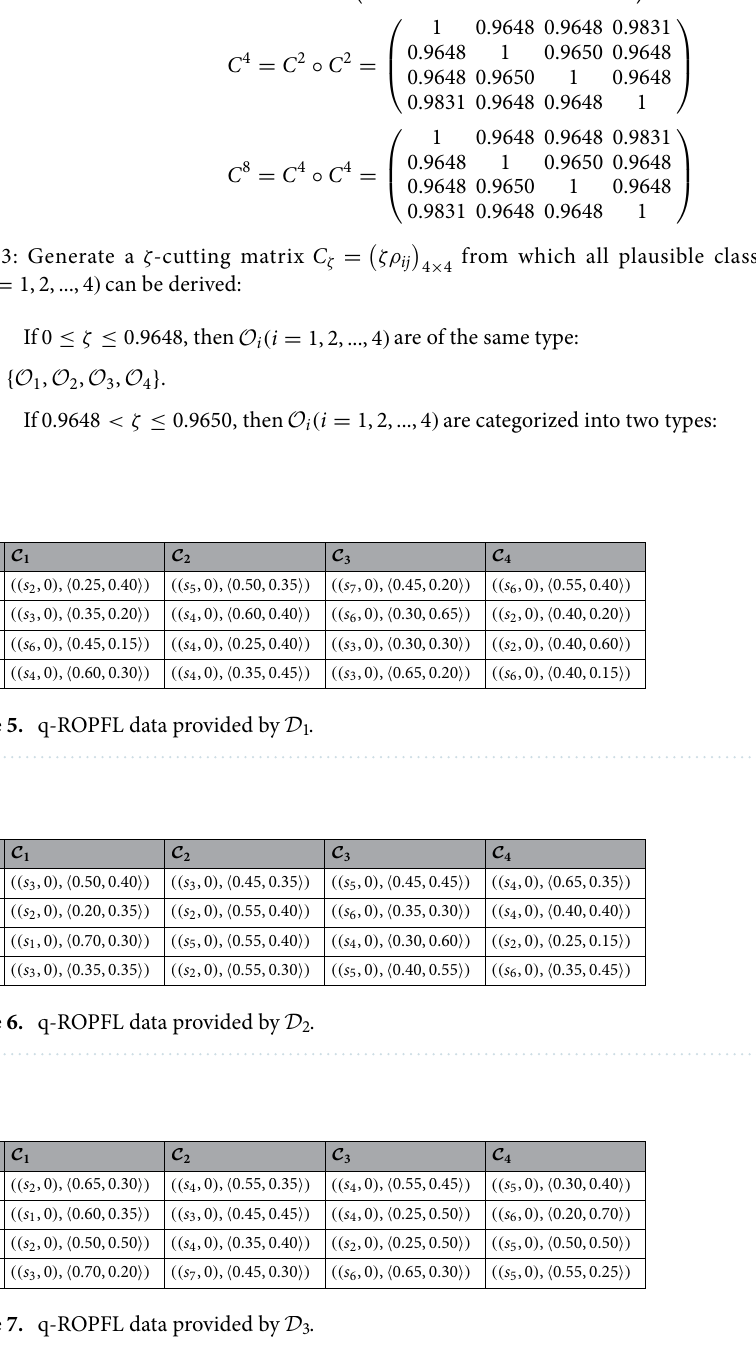
Table 7. q-ROPFL data provided by D 3 .